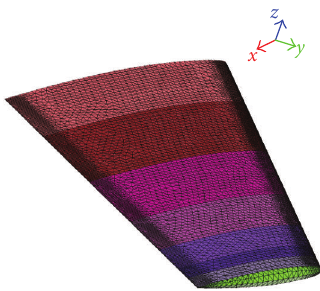
Figure 22: Original ONERA M6 wing grid and patches.